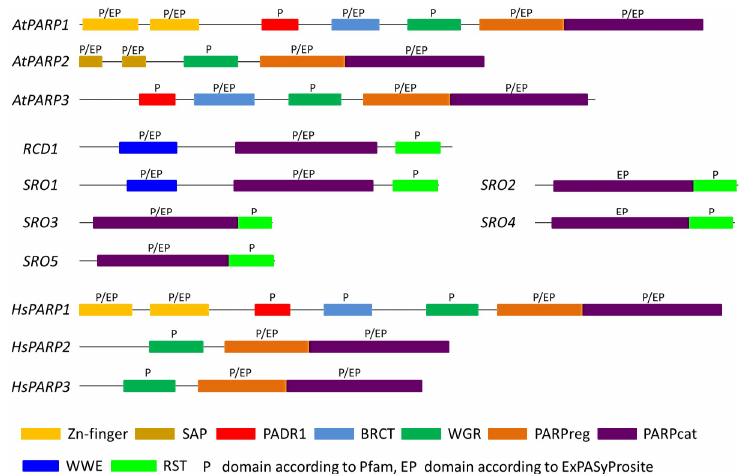
Figure 2. Schematic representation of domains in PARP proteins from humans and Arabidopsis thaliana . Domains were defined according to Pfam 27.0 and are displayed as colored boxes. ExPASY Prosite indicated the existence of PARPcat domains also in SRO2 and SRO4 which are absent in the Pfam analysis. Figure taken from